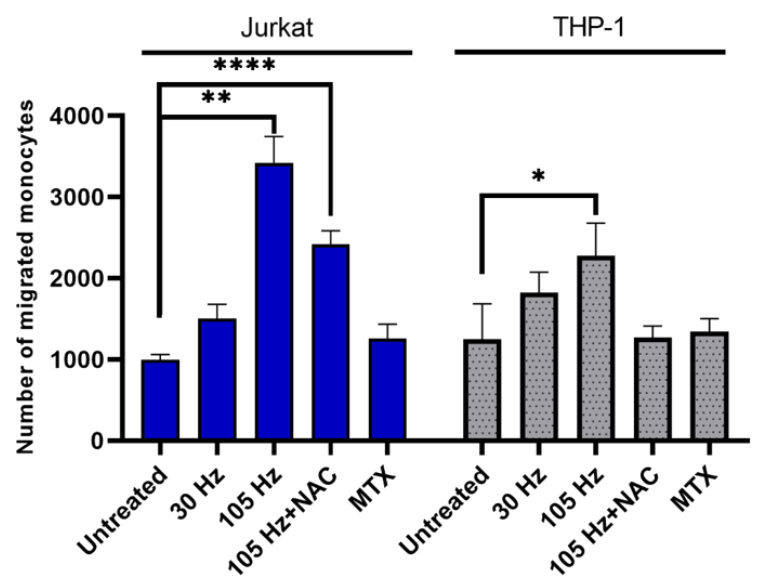
Figure 7. THP-1 monocyte migration is stimulated in response to NTP-exposed cells. The number of migrated (CTFR+) monocytes was increased 24 h post co-culture by NTP-exposed Jurkat or THP-1 cells. Data are presented as mean ± SEM. Significance was calculated using a Kruskal–Wallis test with Dunnett’s post-hoc test (* p < 0.05, ** p < 0.01, **** p < 0.0001).